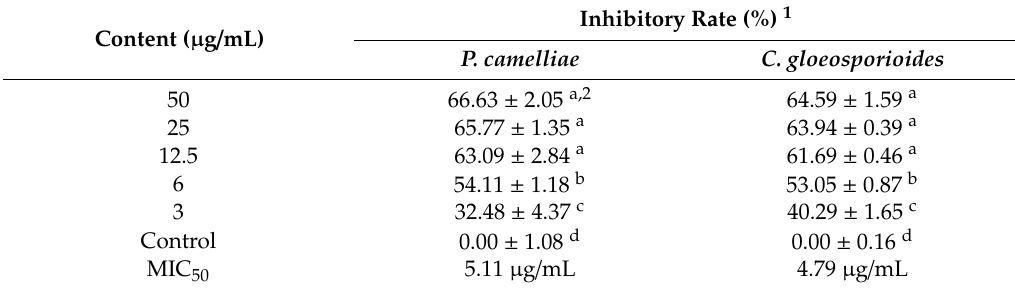
Table 2. Contact antifungal toxicity of B. frutescens leaf SFE-CO 2 extracts against P. camelliae and C. gloeosporioides .